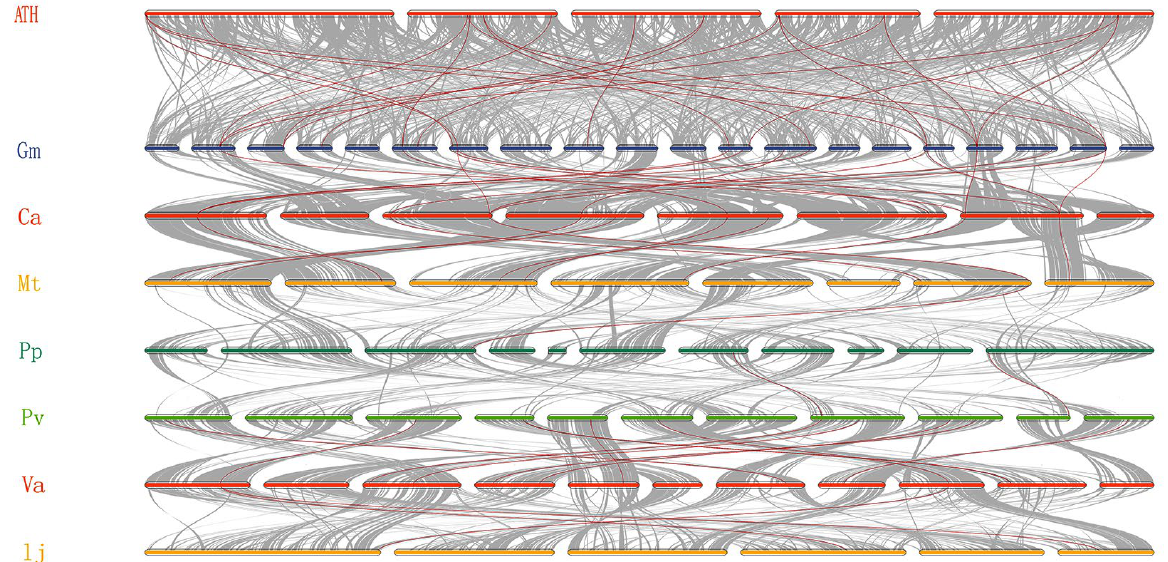
Figure 4. Collinear analysis of CNGC genes in G. max , A. thaliana , and six other legumes (The grey lines in the background indicate collinear regions in the genomes of G. max and other plants, while the red lines highlight collinear CNGC gene pairs. The prefixes ATH , Gm, Mt, Ca, Pp, Lj, Va, and Pv refer to A. thaliana , G. max , M. truncatula , C. arietinum , pigeon pea, L. japonicus , V. angularis , and P. vulgaris , respectively).